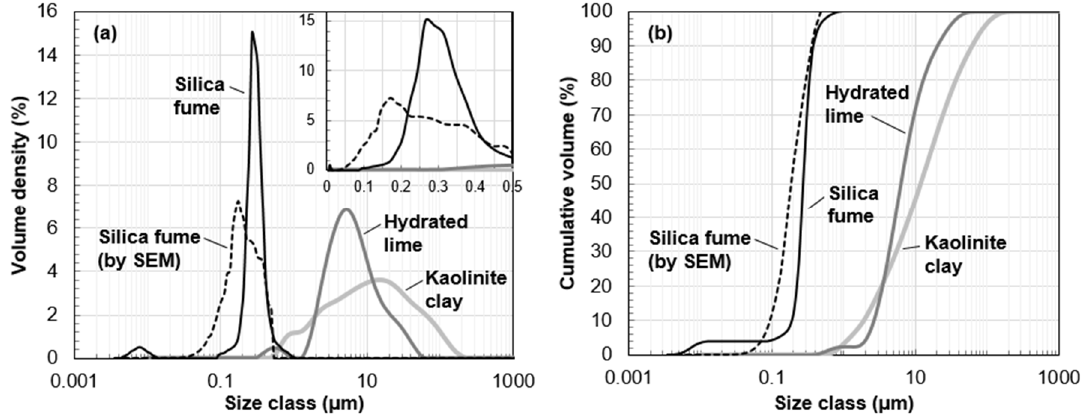
Figure 2. Particle size distributions of raw materials used in kaolinite clay based mortar: ( a ) volume density, and ( b ) cumulative volume. Line curves from laser diffraction method and dot ‐ curve from image ‐ processing method.